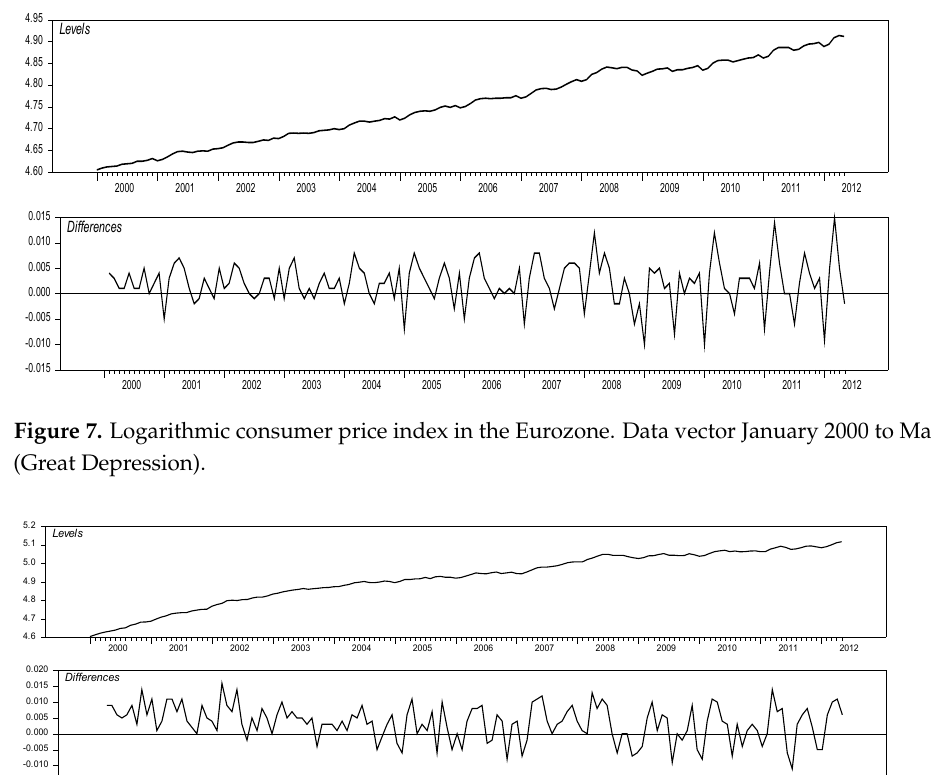
Figure 6. Logarithmic Slovenian price index in the hospitality industry. Data vector January 2000 to May 2012 (Great Depression).